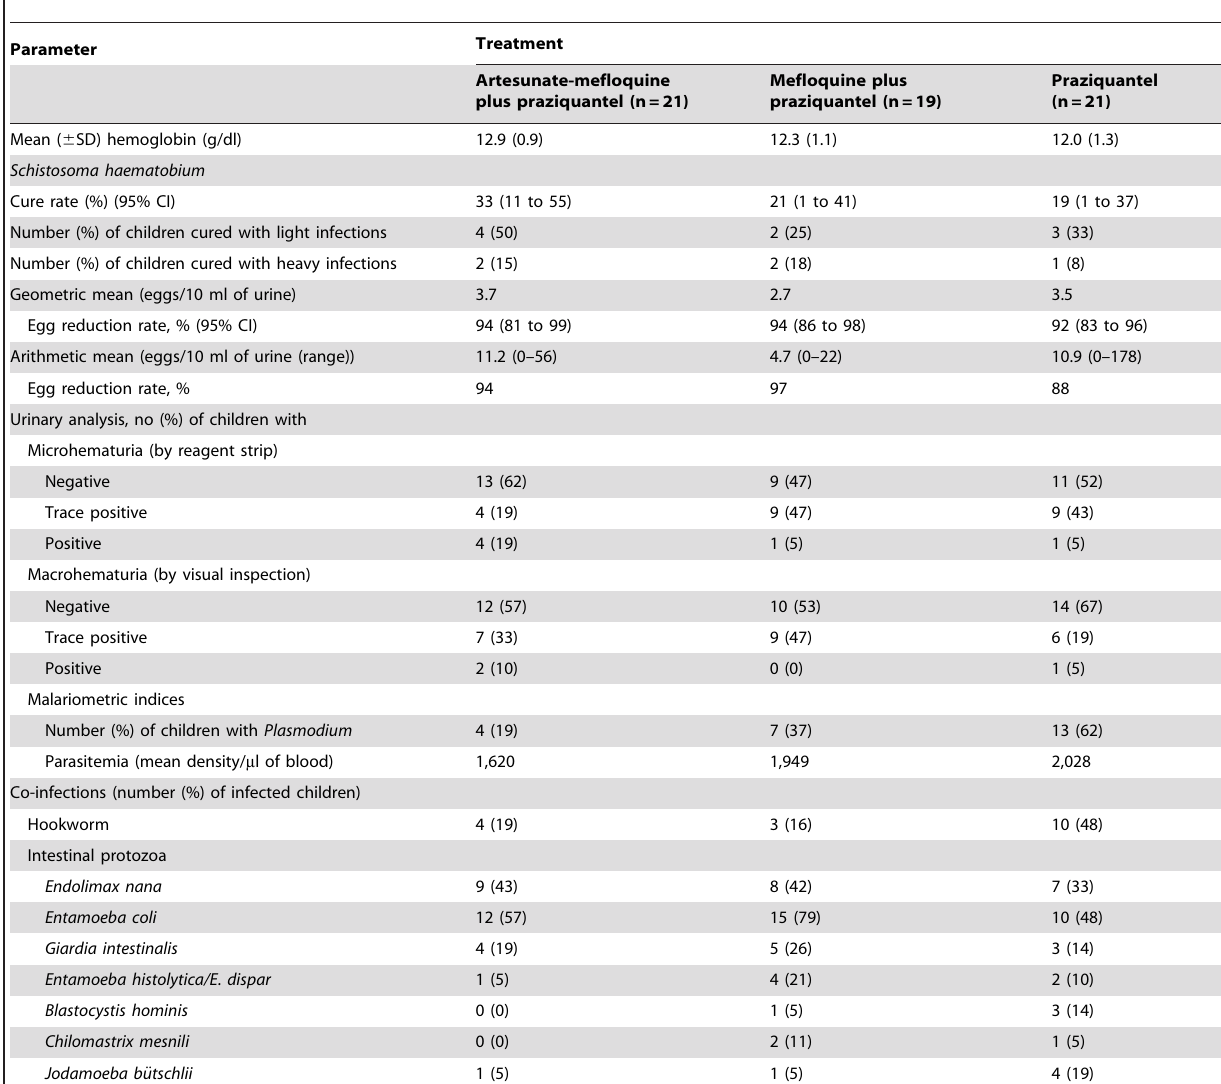
Table 3. Effect of artesunate-mefloquine plus praziquantel, mefloquine plus praziquantel, and praziquantel on S. haematobium and concomitant co-infections at the second treatment